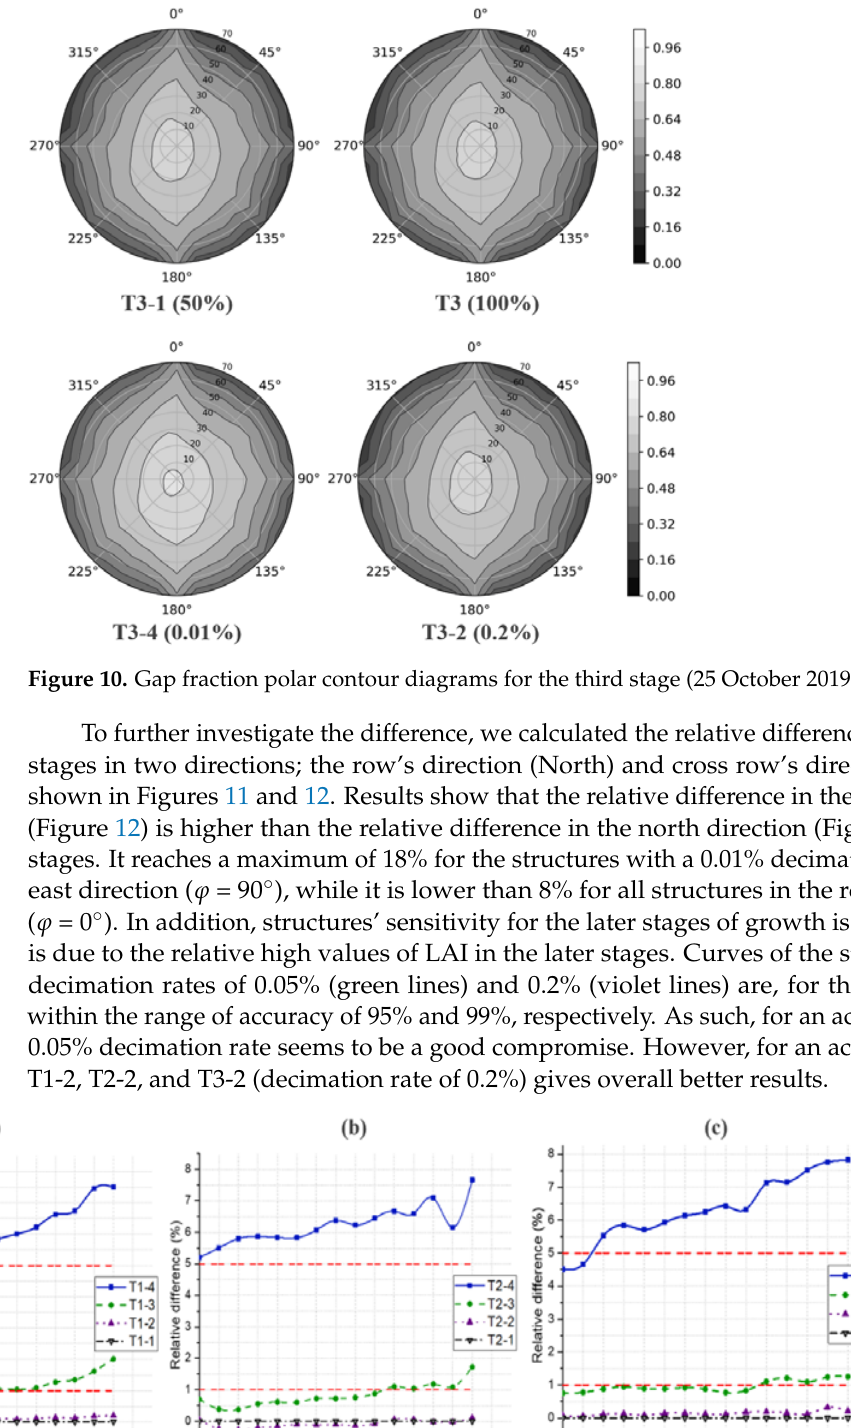
Figure 12. Relative difference of gap fraction (East direction), ( a ) first stage, ( b ) second stage, and ( c ) last stage. The dashed lines in red show the relative difference of 1% and 5%. 4.4. DRF The WPS model was used to investigate the DRF variations for all structures for the three stages of growth. DRF and its components, single scattering and multiple scattering contributions, were calculated over the spectrum range (400–1000 nm) in the solar principal plane for the viewing zenith angles (VZA) from − 70° (forward direction) to +70° (backward direction) with an interval of 5°. Sun zenith and azimuth angles are 40° and 140°, respectively. The scene was bombarded by 9 million photons for the direct sun light and 9 million for the diffuse skylight, which gives the uncertainties for DRF and its components lower than 0.15%. Cyclic boundary conditions for the RT simulations are imposed to emulate an infinite maize canopy. Calculated DRF and its components for the three stages are presented in Figure 13. Through the growing of the maize (from stage 1 to stage 3), the crops show lower reflectance for single scattering (dashed) and higher reflectance for multiple scattering (dashed dot). This is due to the increase and typical low values of LAI (<1) for the three stages.